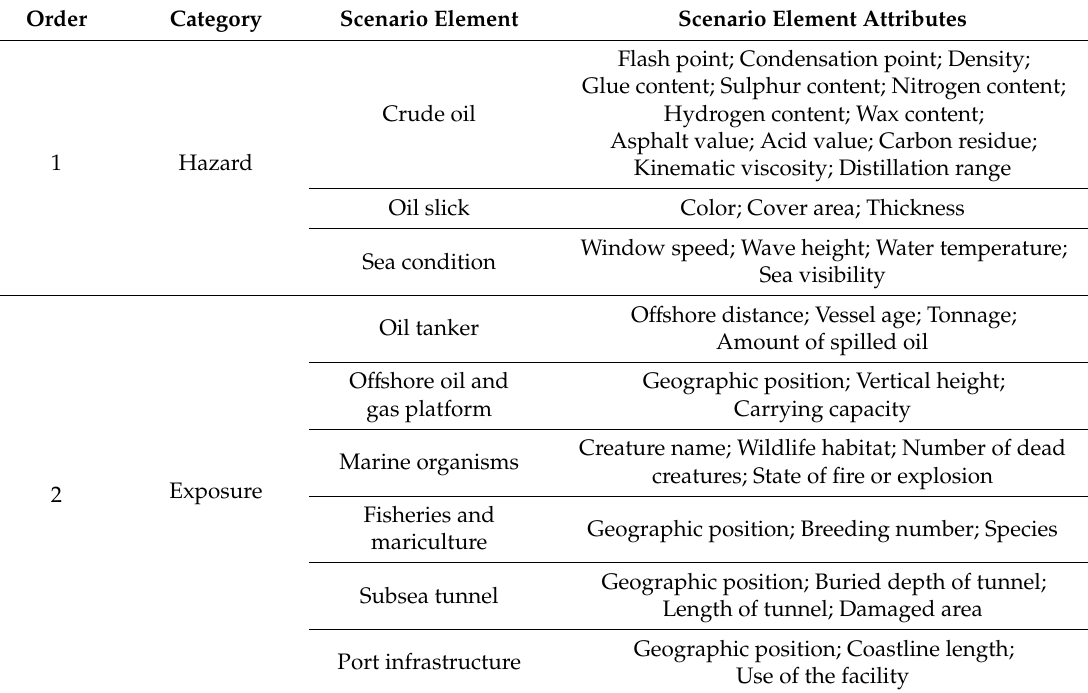
Table 1. Marine oil spill scenario element and scenario element